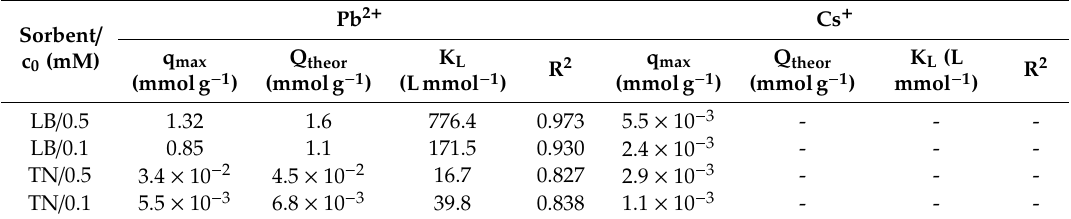
Table 3. Adsorption parameters for Pb and Cs adsorption from model solutions on LB and